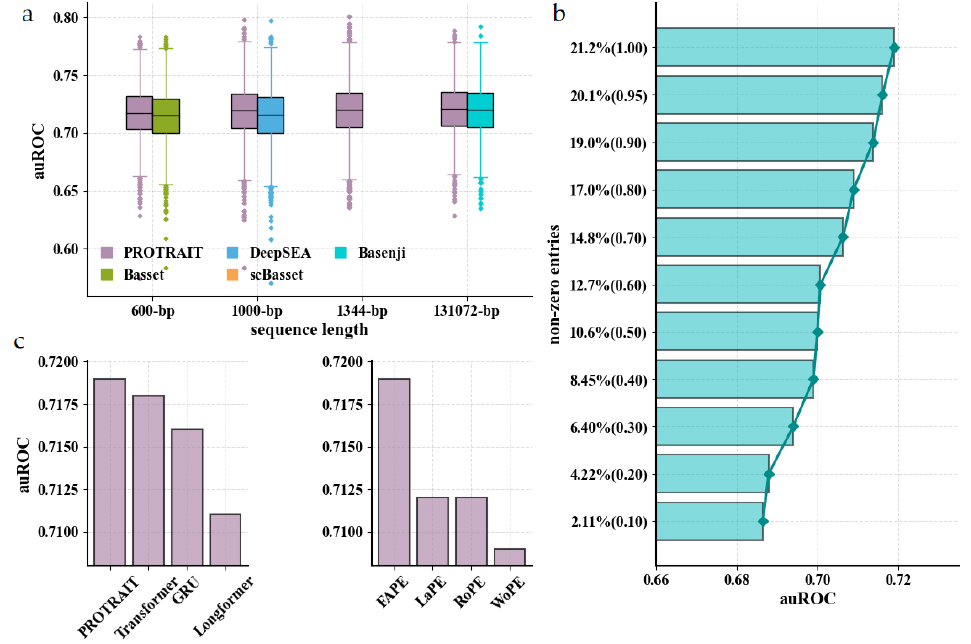
Figure 2. Evaluation of chromatin accessibility prediction approaches for scATAC-seq data. ( a ) auROC comparison of PROTRAIT and different chromatin accessibility prediction approaches, including Basset, DeepSEA, scBasset, and Basenji. ( b ) auROC comparison of PROTRAIT on down- sampled datasets (non-zero entries of labels are 95%, 90%, 80%, 70%, 60%, 50%, 40%, 30%, 20% and 10% of original). ( c ) auROC comparison of the ProbDep Transformer Encoder and its variants ( left ) and the fixed absolute position embedding and its variants ( right